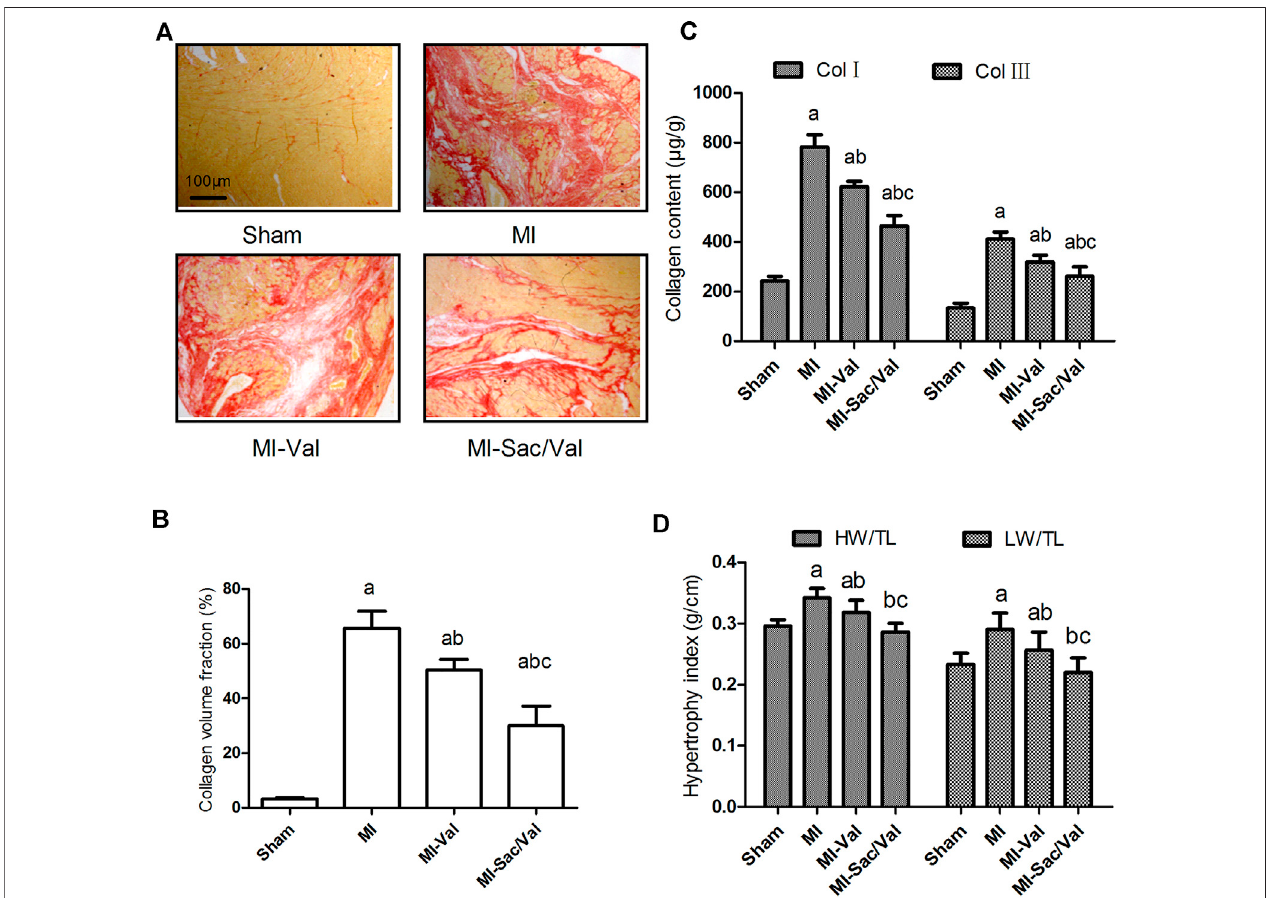
FIGURE 2 | Effects of sacubitril/valsartan on ventricular remodeling in rats after myocardial infarction. (A) Representative photomicrographs of collagen volume in the infarcted myocardium (Picrosirius red staining, scale bars (cid:1) 100 μ m). (B) Myocardial collagen volume fraction quanti fi ed by digital planimetry. (C) Myocardial type Ⅰ and type Ⅲ collagen content detemined by ELISA. (D) Myocardial hypertrophy expressed as heart weight to tibia length ratio (HW/TL) and left ventricular weight to tibia length ratio (LW/TL). Results are mean ± SD ( n (cid:1) 8); Col Ⅰ , type Ⅰ collagen; Col Ⅲ , type Ⅲ collagen; HW/TL, heart weight to tibia length ratio; LW/TL, left ventricular weight to tibia length ratio; MI, myocardial infaction; Val, valsartan; Sac/Val, sacubitril/valsartan. Results are mean ± SD ( n (cid:1) 8); a P < 0.05 vs. Sham;b P < 0.05 vs. MI; c P < 0.05 vs. MI-Val.